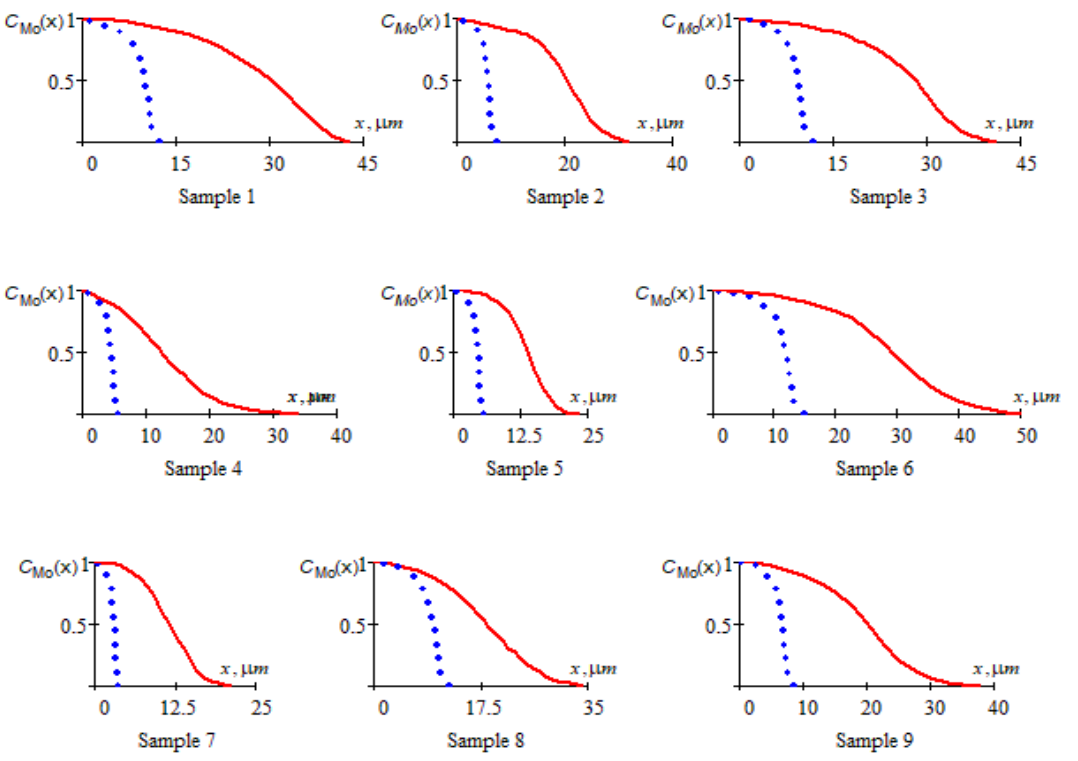
Figure 1. Distribution of volume fractions of molybdenum in the diffusion zone of each